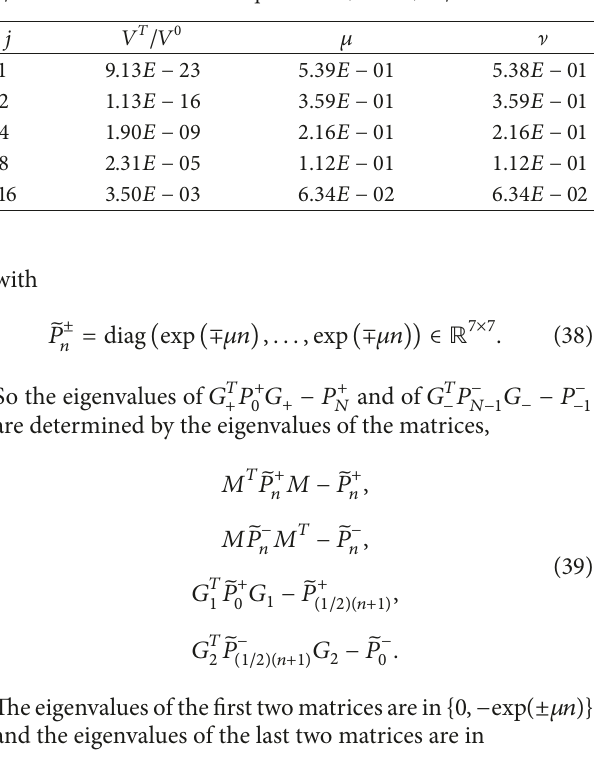
Table 2: The number of cells on each edge is 𝑁 = 200 , with Δ𝑥 = 1/200 . The CFL constant is equal to one; that is, Δ𝑡/Δ𝑥 = 1